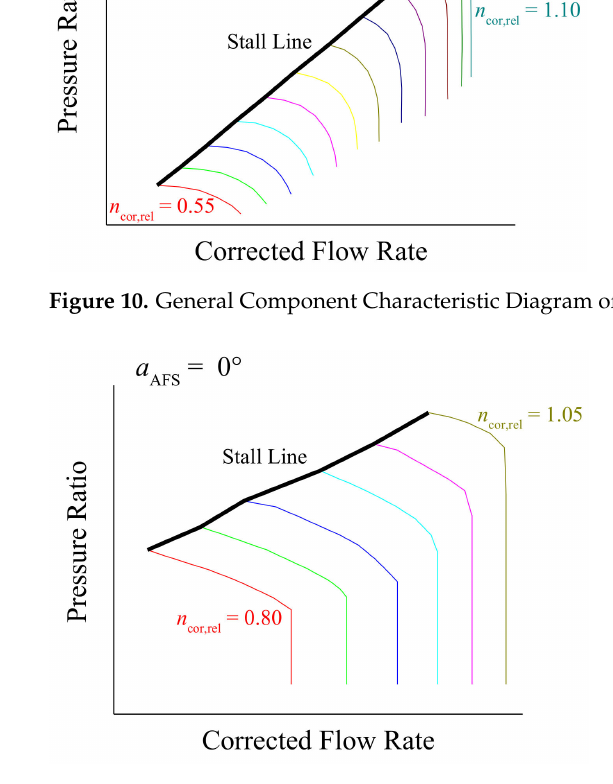
Figure 11. General Component Characteristic Diagram of AFS (IGV = 0 ◦